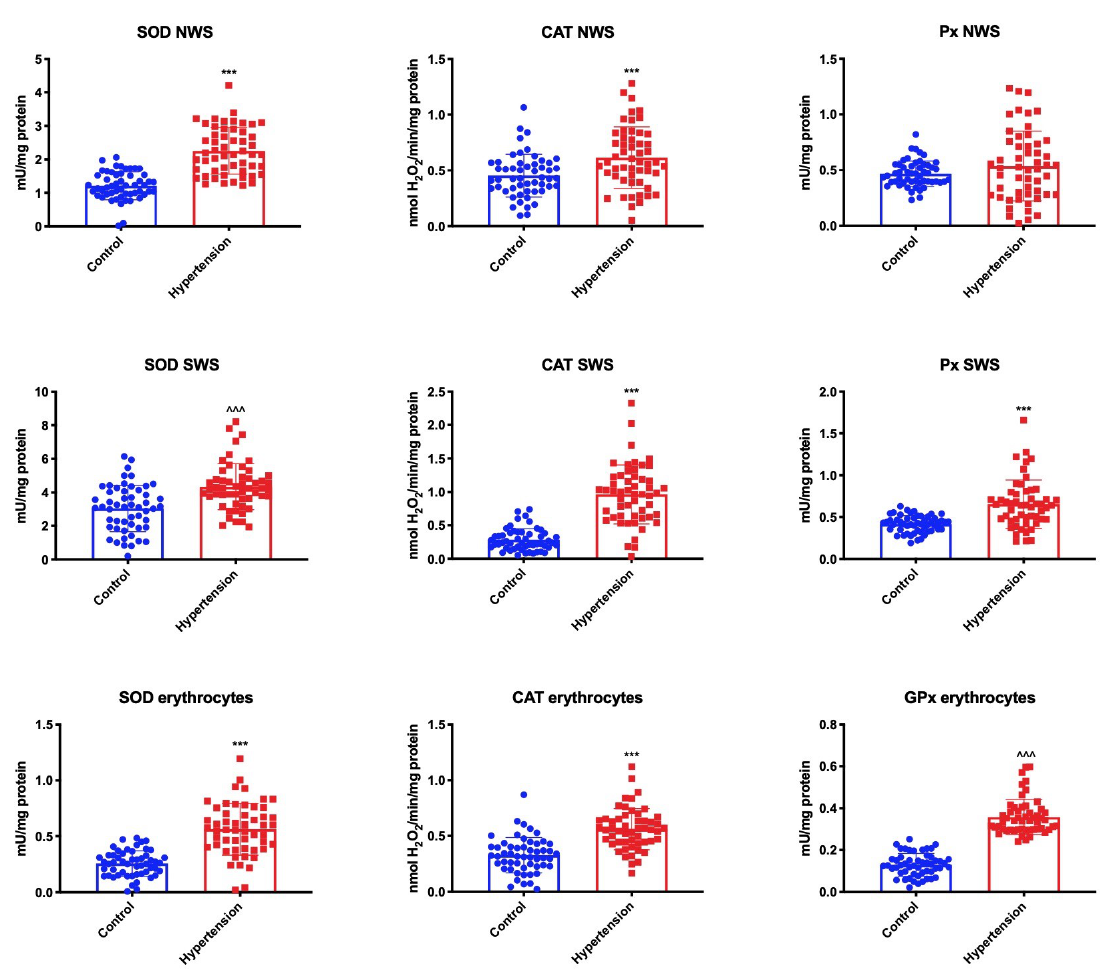
Figure 1. Antioxidant enzymes in children with hypertension and healthy controls. CAT—catalase; GPx—glutathione peroxidase; NWS—non-stimulated whole saliva; Px—salivary peroxidase; SOD—superoxide dismutase; SWS—stimulated whole saliva. Di ff erences statistically